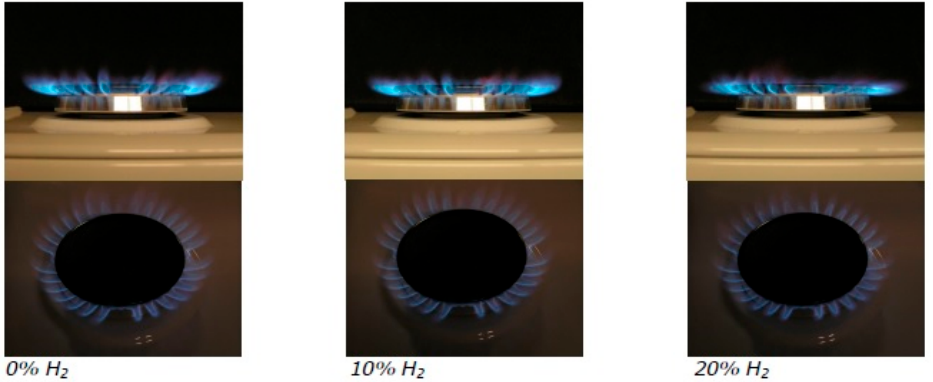
Figure 3. Gas cooker ring fuelled by hydrogen ‐ enriched natural gas (reproduced from [40]).